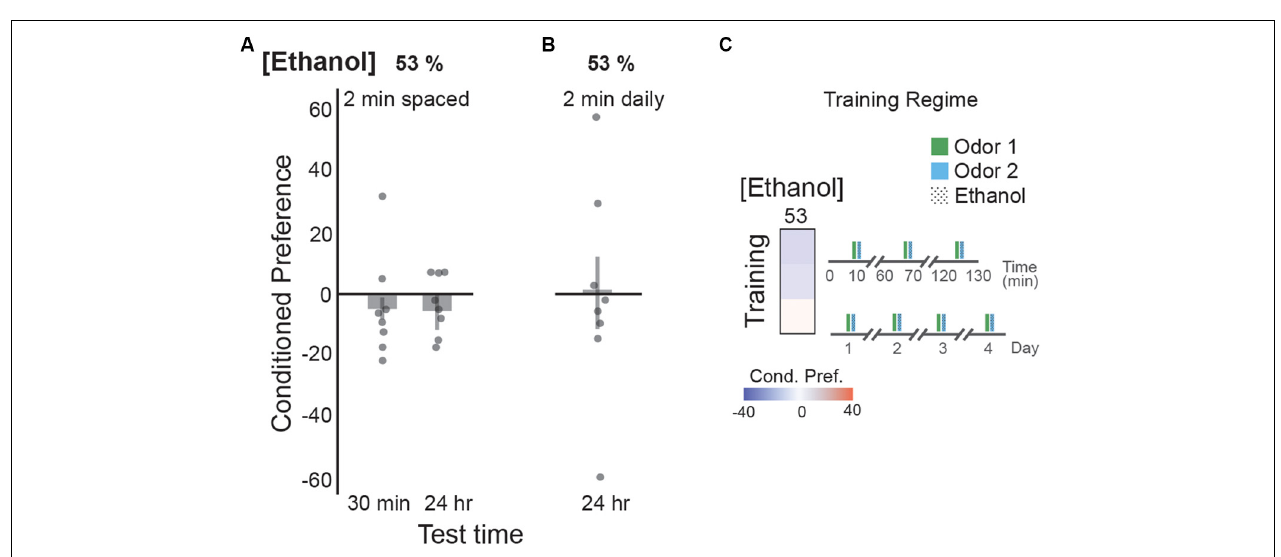
FIGURE 6 | Memory is formed for ethanol intoxication, not odors. (A) Two minute exposure durations resulted in no preference valence with the spaced-training paradigm at 30 min, or 24 h post-training with a 53% ethanol concentration. (B) Single 2 min duration exposures across 4 days is not sufficient to form a cue-memory with a 53% ethanol concentration, when tested on the fifth day. Two minute exposures are not sufficient to yield increased locomotor responses that correlates with ethanol intoxication (Kaun et al., 2011). (C) Heat map summaries suggest no strong preference valence for either training paradigm with a 2 min exposure duration. Schematic of the training regimes are depicted. Bars represent mean + / − standard error. N ∼ 8 per group where individual data points represent N = 1 ( ∼ 100 flies)